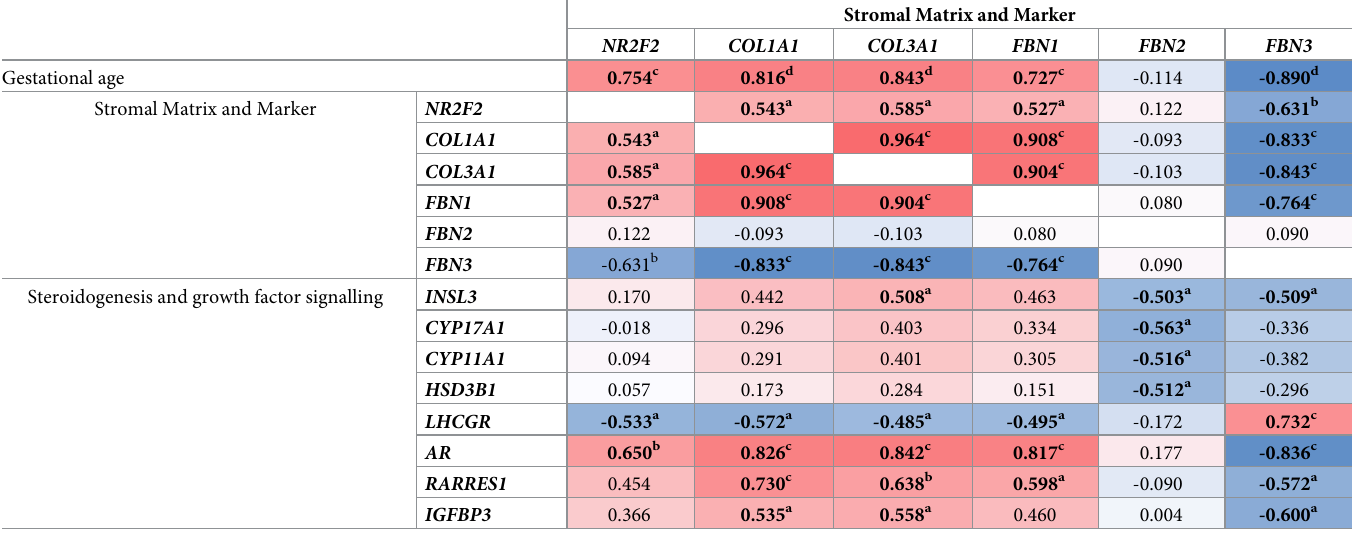
Table 2. Pearson’s correlation coefficients between levels of expression of genes for stromal matrix and marker with other genes for stromal matrix and marker and thecal cells and gestational age. The darker the background colour the more significant the correlation is. Blue indicates a negative correlation and red indicates a positive correlation. ( P -values: a < 0.05, b < 0.01, c < 0.001, d < 0.0001).